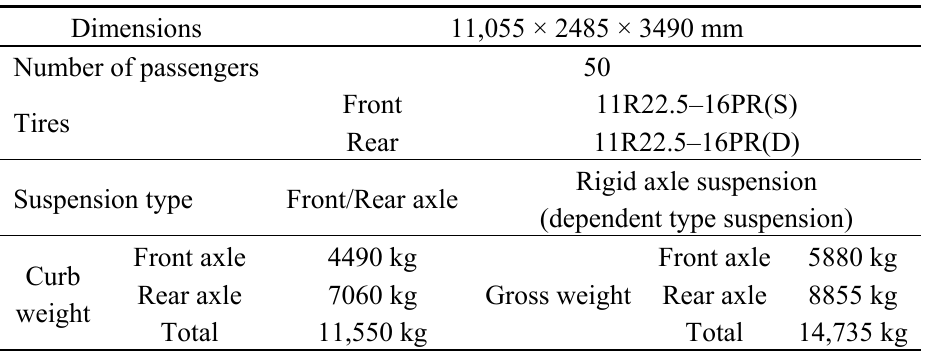
Table 1. Specifications of the base model.